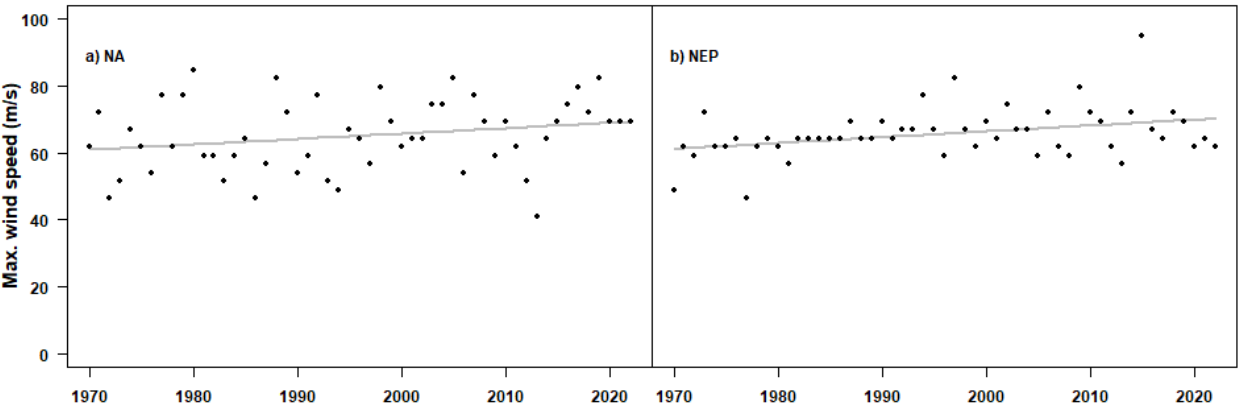
Figure 4. Annual maximum speed and relative trend in ( a ) the NA basin ( p < 0.1), and ( b ) the NEP basin ( p < 0.01).